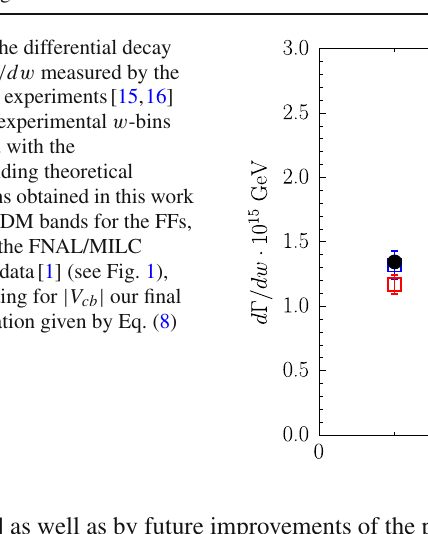
Fig. 4 The differential decay width d (cid:6)/ d w measured by the two Belle experiments[15,16] in the 10 experimental w -bins compared with the corresponding theoretical predictions obtained in this work using the DM bands for the FFs, based on the FNAL/MILC synthetic data[1] (see Fig. 1), and adopting for | V cb | our final determination given by Eq. (8)